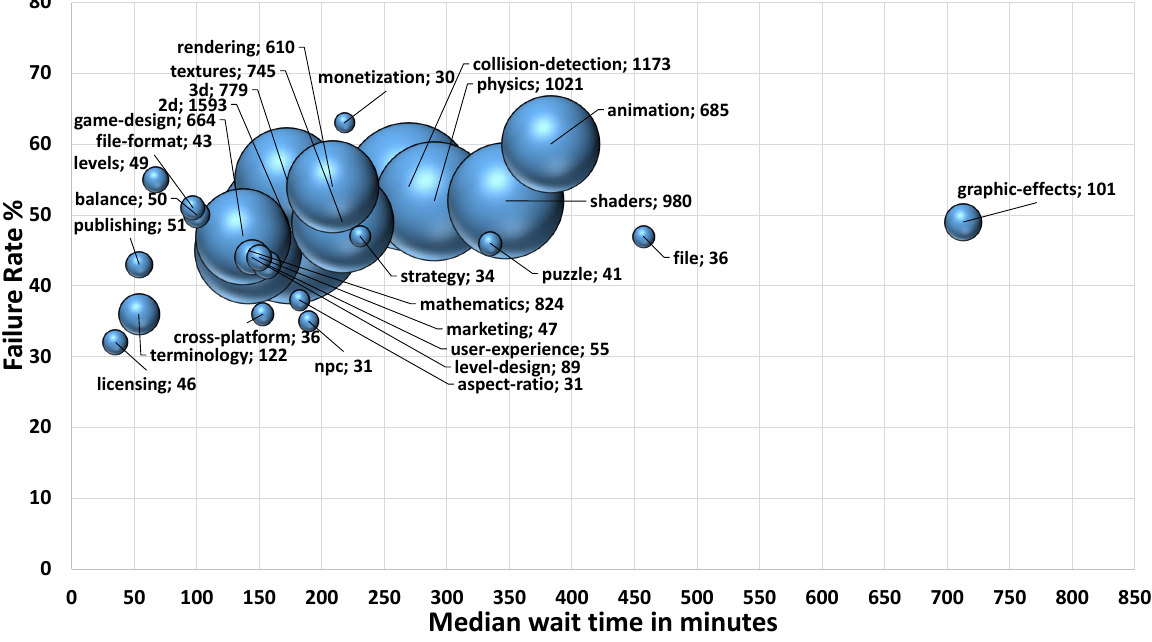
Figure 7. Failure Rate and Median Wait Time for most popular